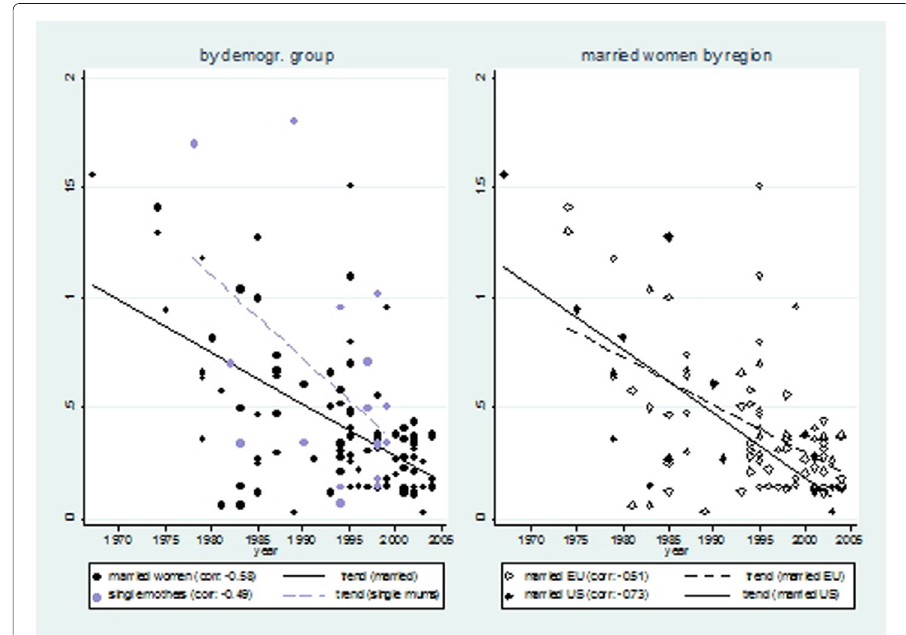
Fig. 3 Time trend in wage elasticities of married women and single